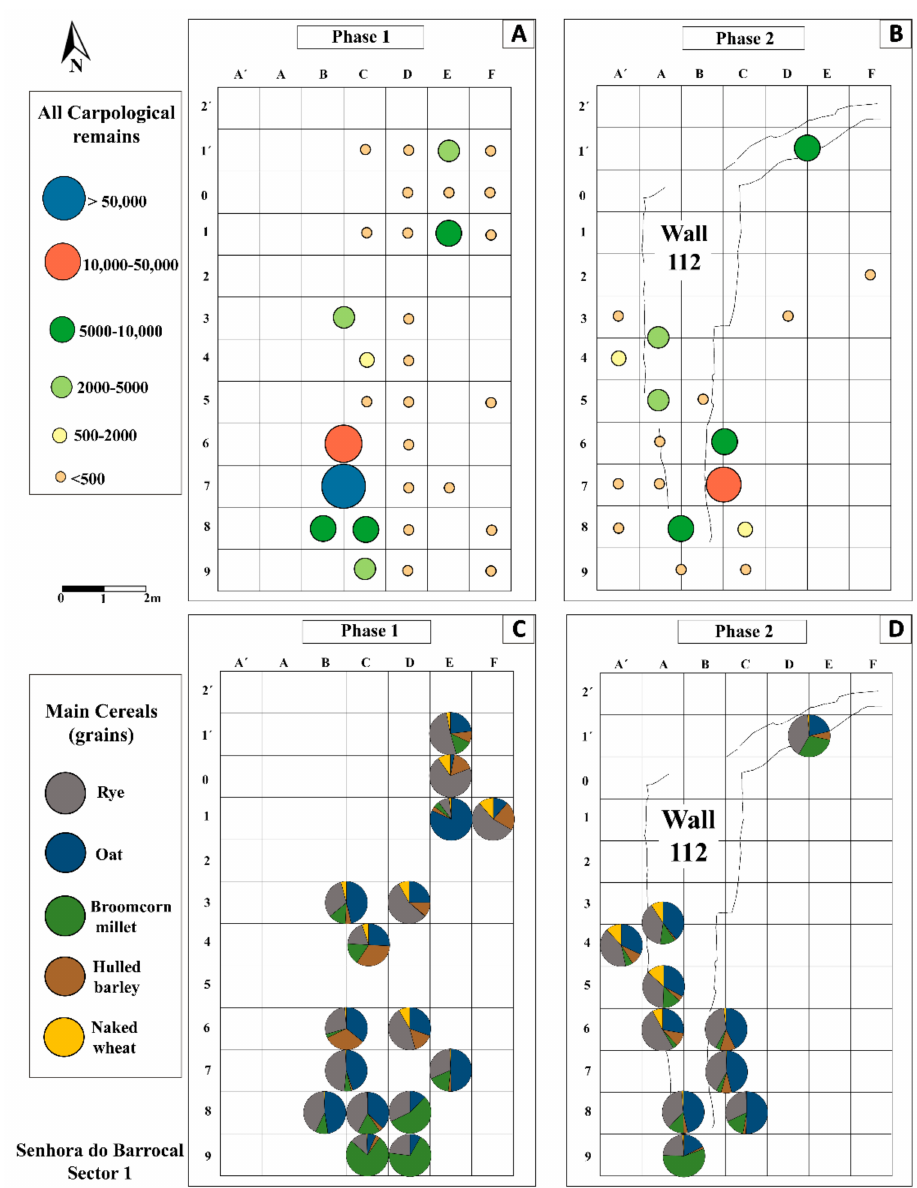
Figure 6. Square analysis per phase. All fruits/seeds ( A , B ); main cereal grains ( C , D ); only units. Results from the first moment as well from row G onwards revealed few remains and for that reason are not